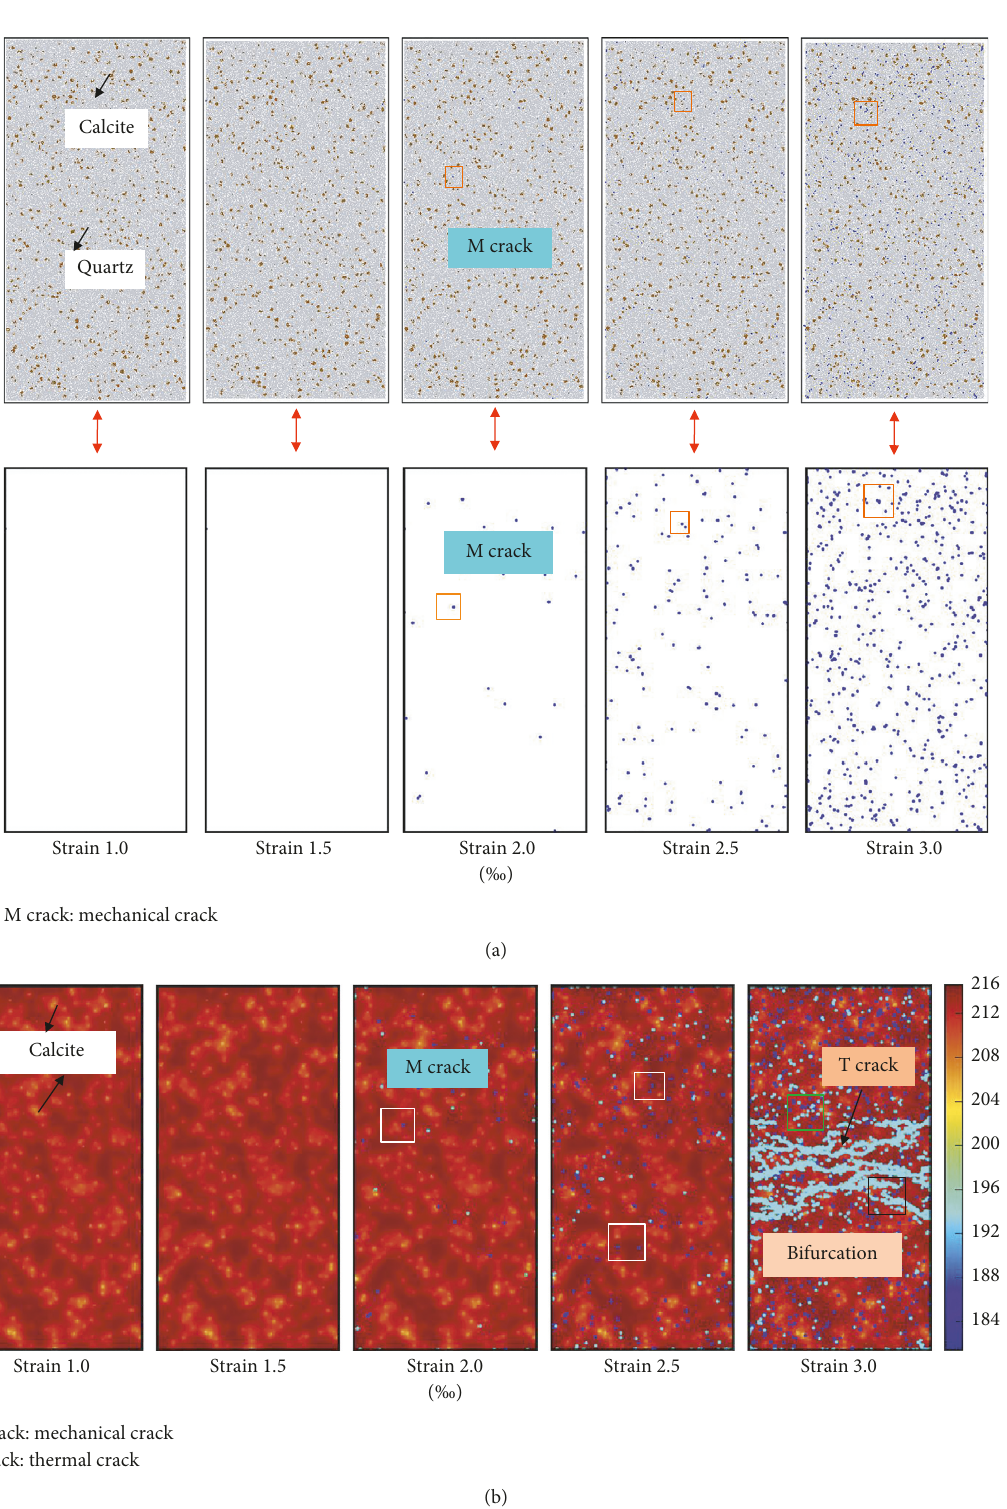
Figure 12: The failure characteristics under the different strains. The failure distribution of MCS material (a) without considering temperature load and (b) considering temperature load